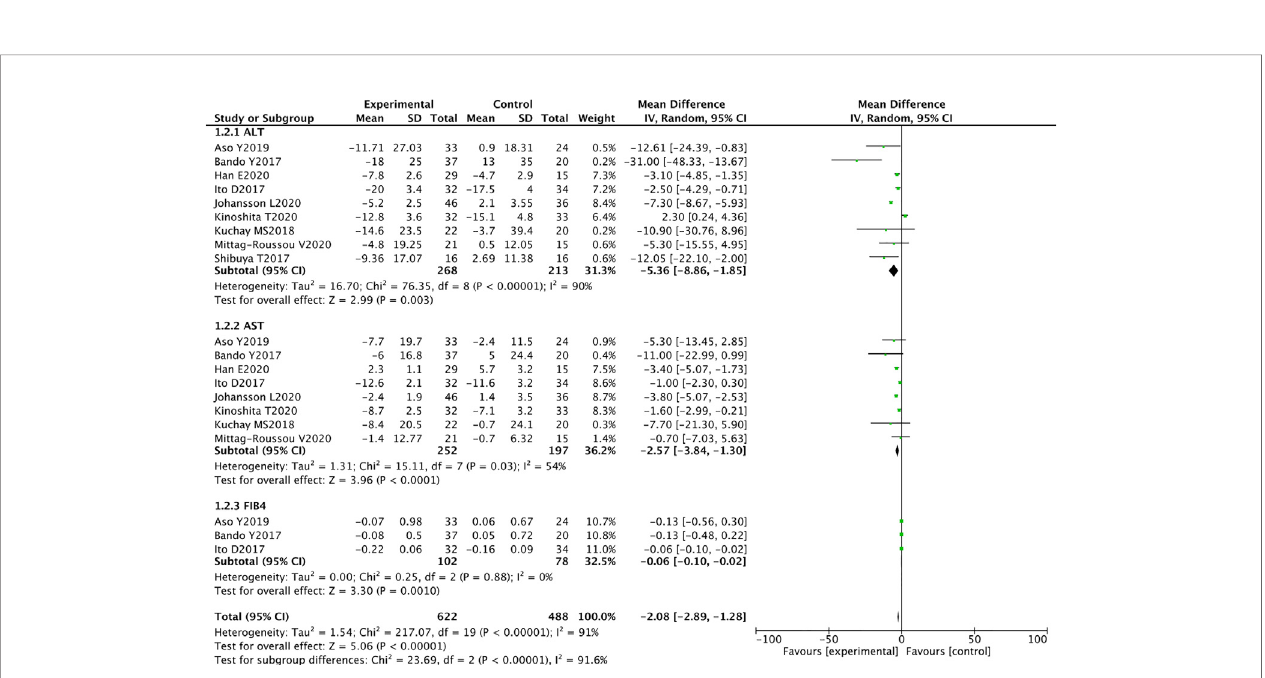
FIGURE 4 | Meta-analysis of the effect of SGLT2 inhibitors on liver function compared with the control group.